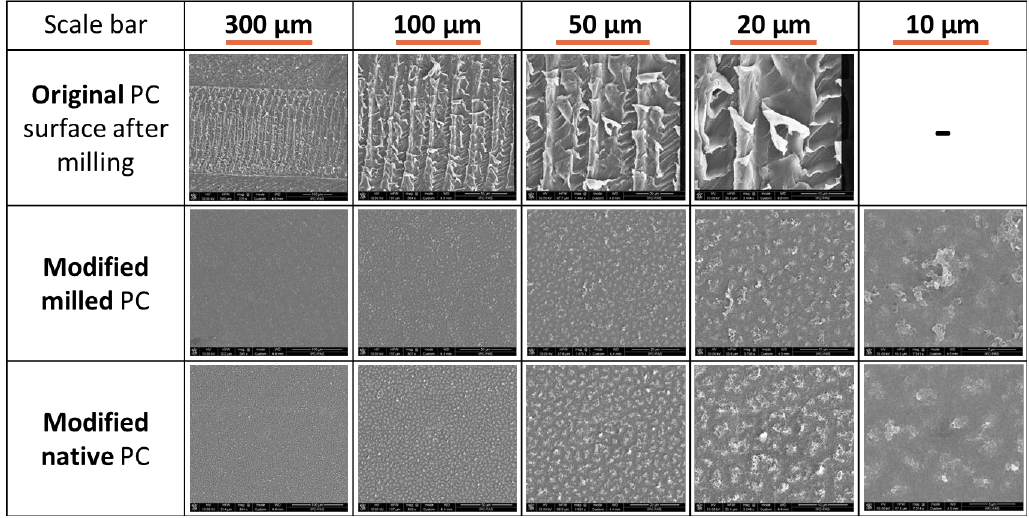
Figure 3. Scanning electron micrographs of original and modified PC with the use of 20% solution of NH 4 OH for 2 h at room temperature.